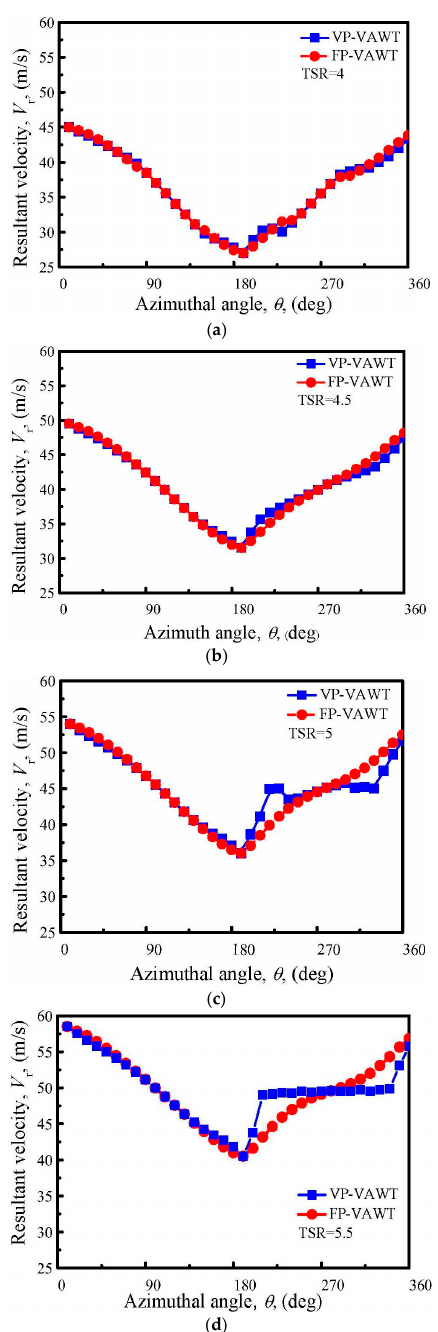
Figure 12. Resultant velocity as a function of the azimuthal angles in VP-VAWTs and FP-VAWTs. ( a ) TSR = 4; ( b ) TSR = 4.5; ( c ) TSR = 5; ( d ) TSR =